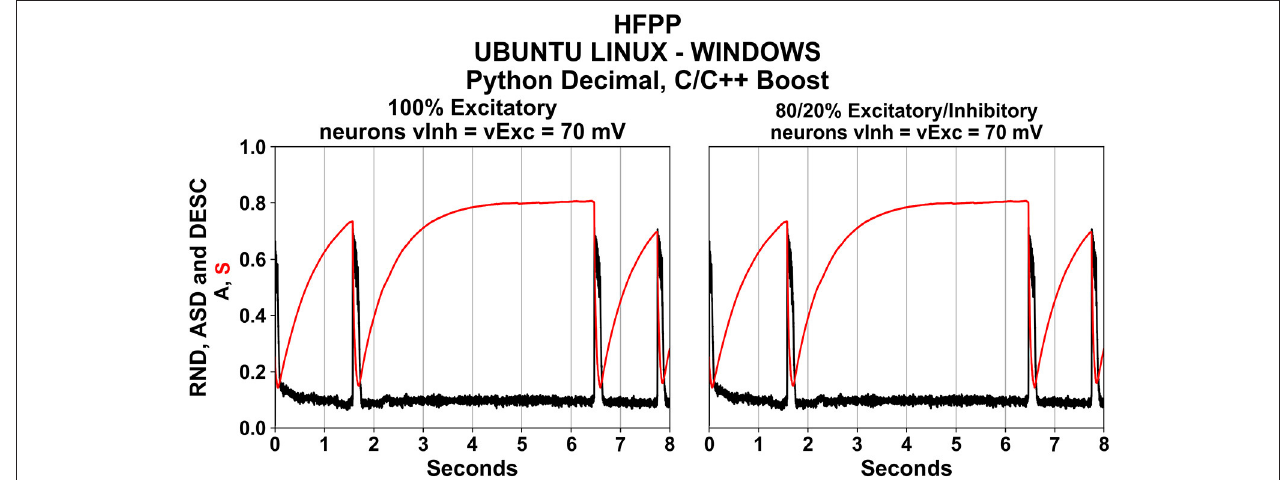
FIGURE 3 | Using HFPP guaranteed the numerical replicability among simulations for different OSs and